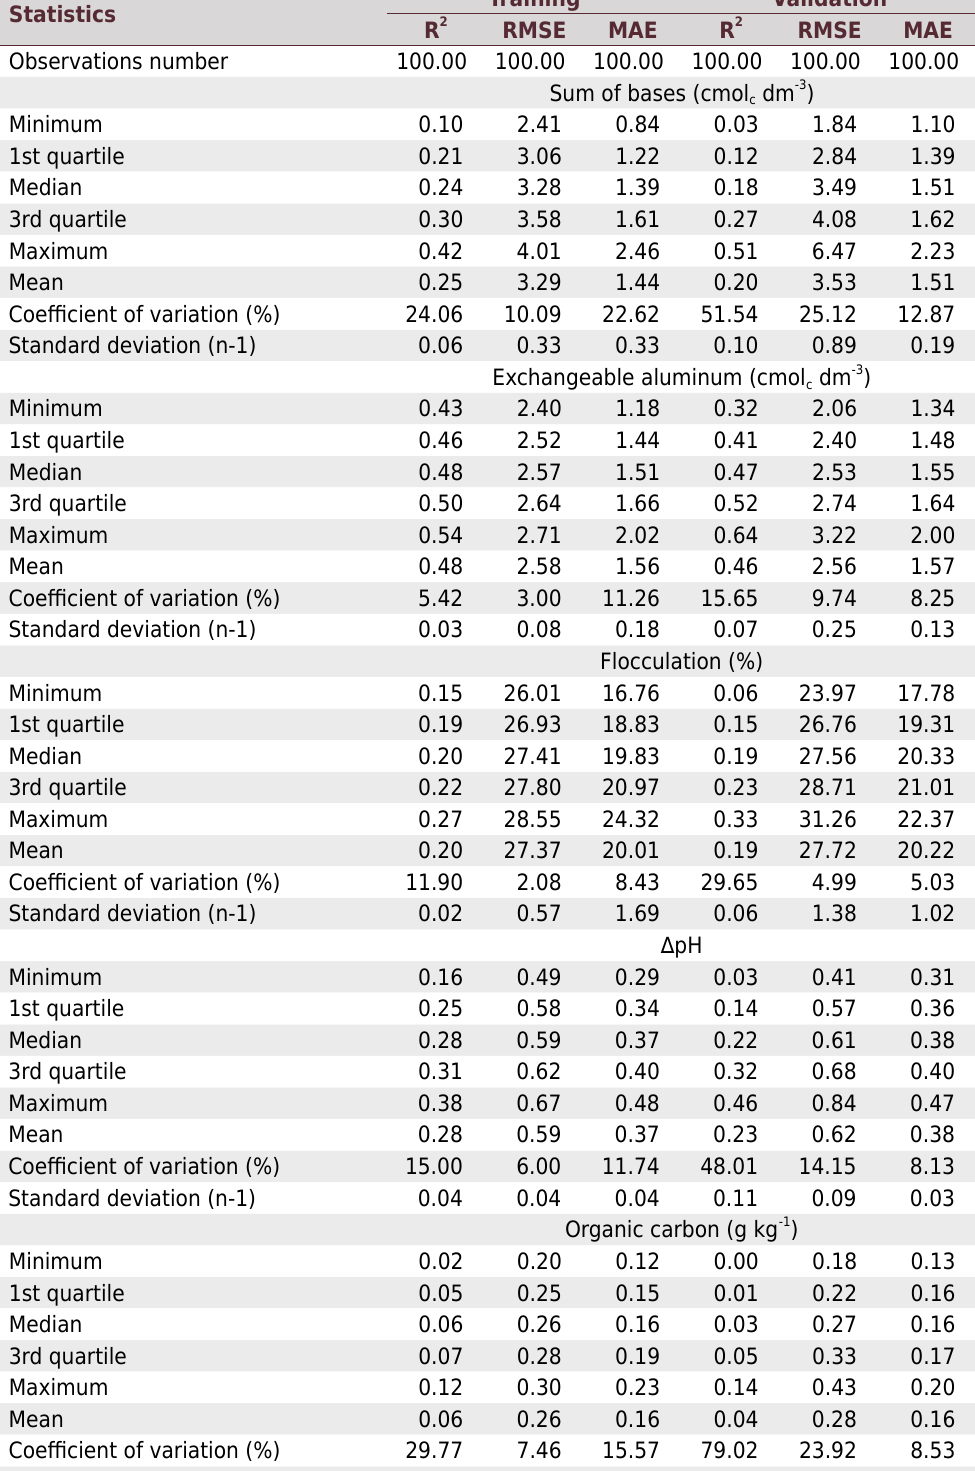
Table 4. Descriptive statistics of estimated parameters and statistical cross-validation by machine learning algorithm (Extremely randomized trees) after 100-fold